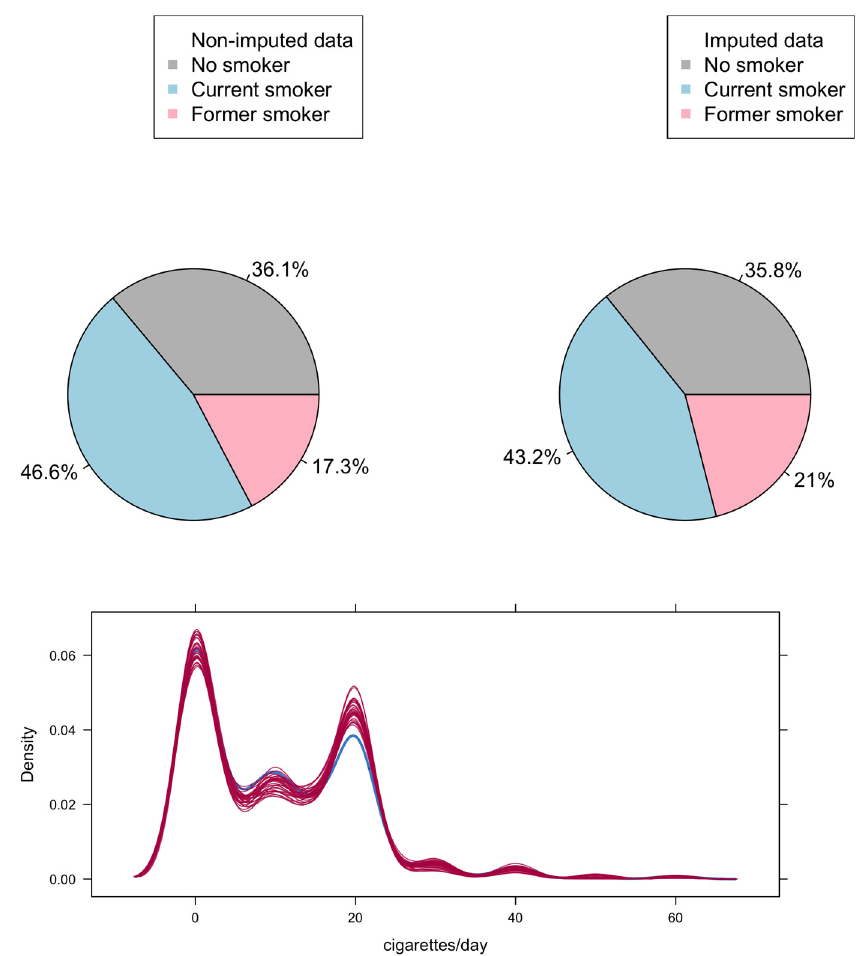
Figure 1. Complete cases data set and the imputed data sets: distribution of smoking habit (average of the imputed) and of number of cigarettes/day (blue line complete, red lines imputed).